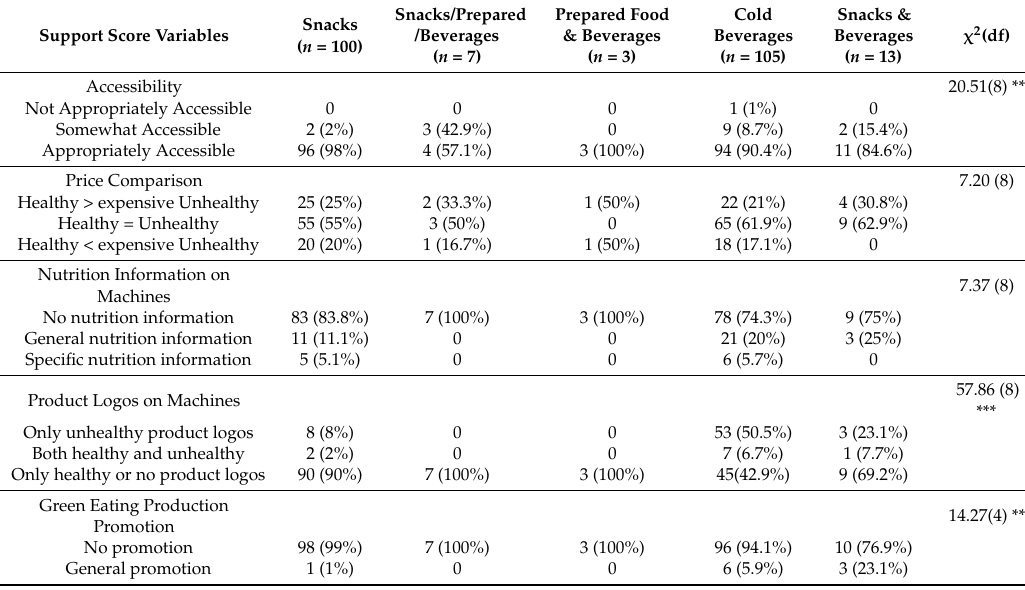
Table 6. Distribution of support question answers for all vending machines ( n =